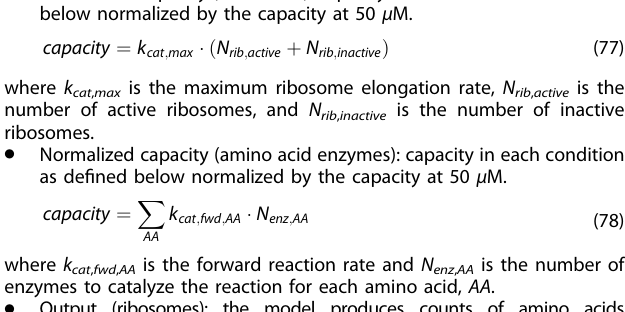
data in Bremer et al. 30 . Simulation data for perturbed ppGpp conditions comes from Simulation set 11 (excluding the fi rst 2 generations to allow for normalization to the adjusted ppGpp concentration). Growth rate comes directly from simulation output. RNA/protein mass ratio is determined by the RNA mass divided by protein mass at each time step. A moving average is applied to each cell trajectory data series (multiple generations from a single starting seed) with a window of 200 time points before the mean across all values is